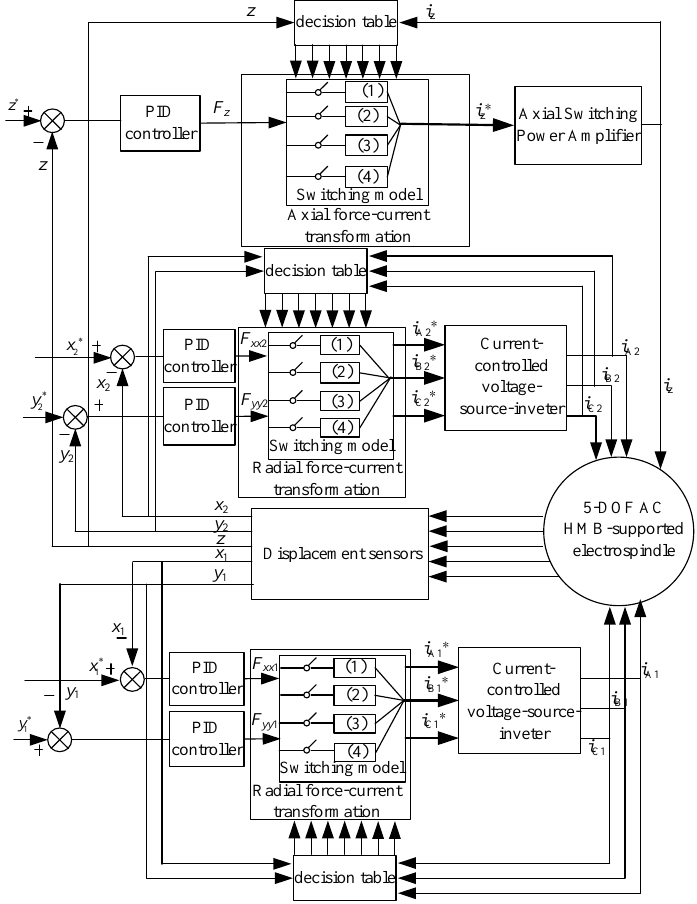
Figure 5. The basic block of control algorithm for control system.